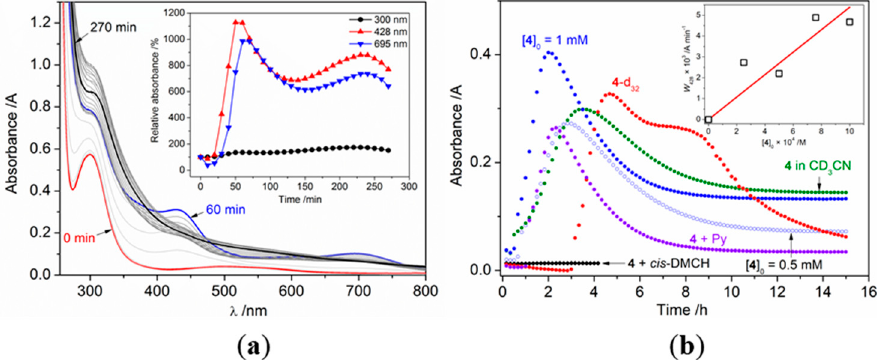
Figure 6. ( a ) UV / Vis spectra of 1 – 5 in acetonitrile (1 × 10 − 3 M) at room temperature. ( b ) Changes in absorbance at 492 nm for 1 – 3 and 5 . The dependences for complex 1 were measured in the absence (empty circles) and in the presence (solid circles) of pyridine (0.01 M).